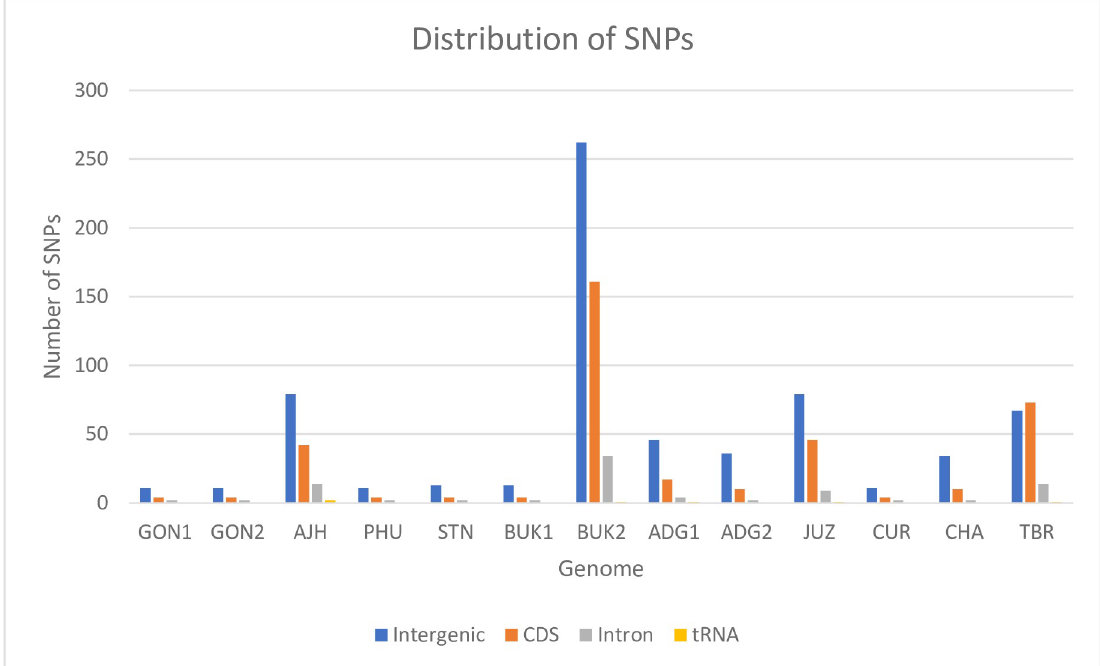
Fig 3. Distribution of SNPs in a panel of 13 potato plastomes. The number of SNPs and their distribution across different regions show that the majority of the SNPs are present in intergenic regions. However, the BUK2, AJH, JUZ, and TBR plastomes also have many SNPs in the CDS